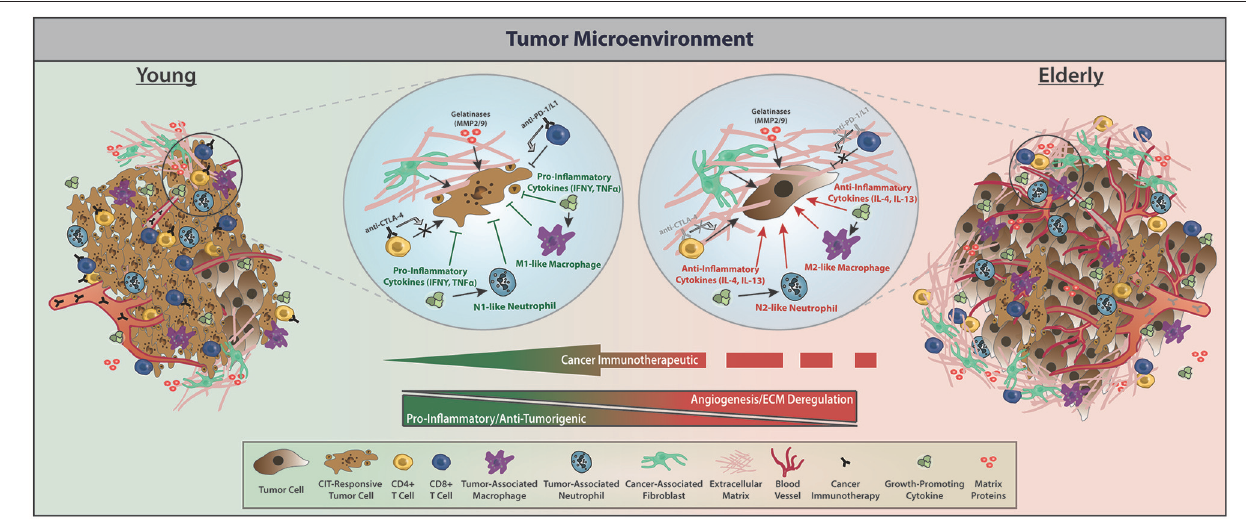
FIGURE 2 | With respect to factors affecting CIT, the TME of young vs. elderly hosts differs predominately in immune infiltration and cytokine profile, regulation of angiogenesis and the ECM, as well as interactions between tumor and stromal cells. Within the young TME, increased presence of CIT-responsive tumor cells, less angiogenesis and ECM deregulation, elevated immune infiltration, and elevated pro-inflammatory cytokines give rise to a relatively more CIT-responsive TME, subsequently contributing to apoptotic tumor cells with reduced proliferation. Within elderly TMEs, relatively bigger tumors but with fewer CIT-responsive tumor cells, more angiogenesis and ECM deregulation, decreased immune infiltration, and elevated anti-inflammatory cytokines contribute to reduced apoptosis and increased proliferation subsequently enabling tumor growth. Treatment with CIT in elderly individuals triggers a phenotypic landscape remodeling toward a TME with young characteristics through enhancing the function of effector T cells following CIT and promoting a pro-inflammatory TME. Within elderly hosts, the tumor stroma permits a deregulated ECM that creates a biophysical barrier preventing effective function of effector T cells, but CIT combinations may help alleviate these age-related TME dysfunctions and decrease tumor burden. Of note—while we acknowledge that there are dormant and/or tumor initiating cells, we only depict CIT responders vs. non-responders within the TME (Gonzalez et al.,